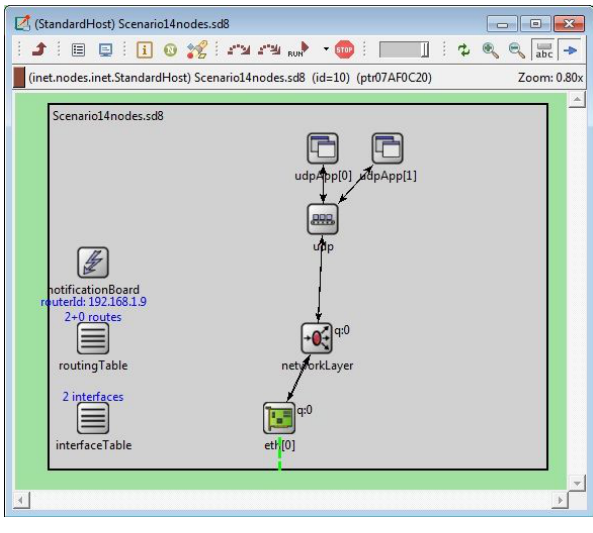
Figure 6. Module of class standardHost .